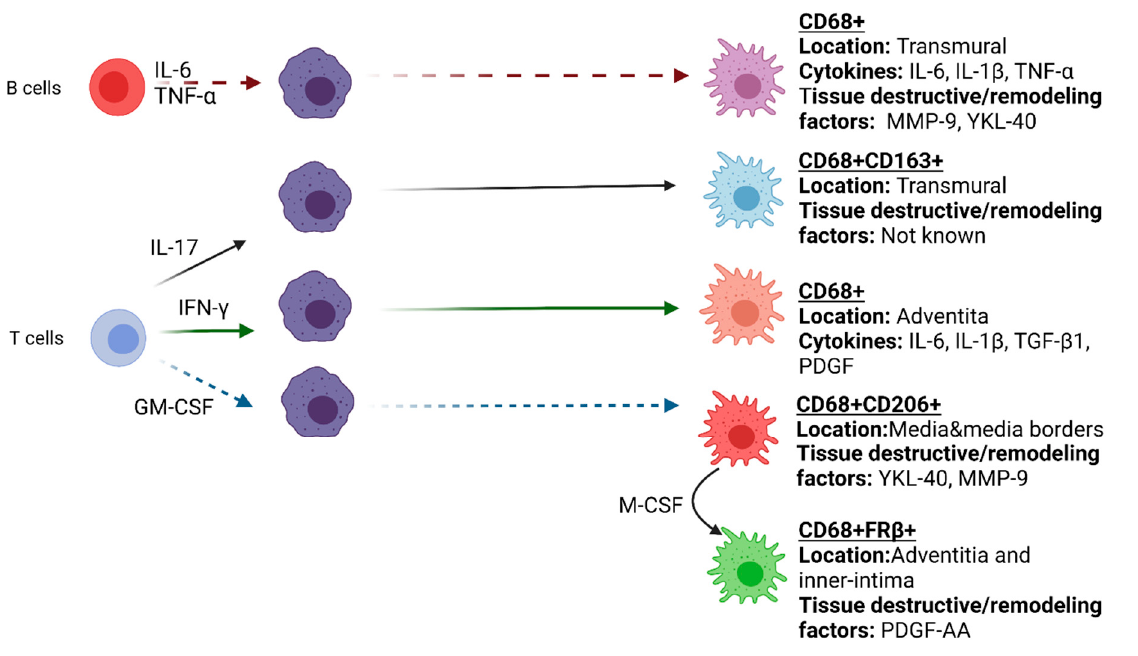
Figure 2. Functional heterogeneity of macrophages in GCA affected vessel-wall.